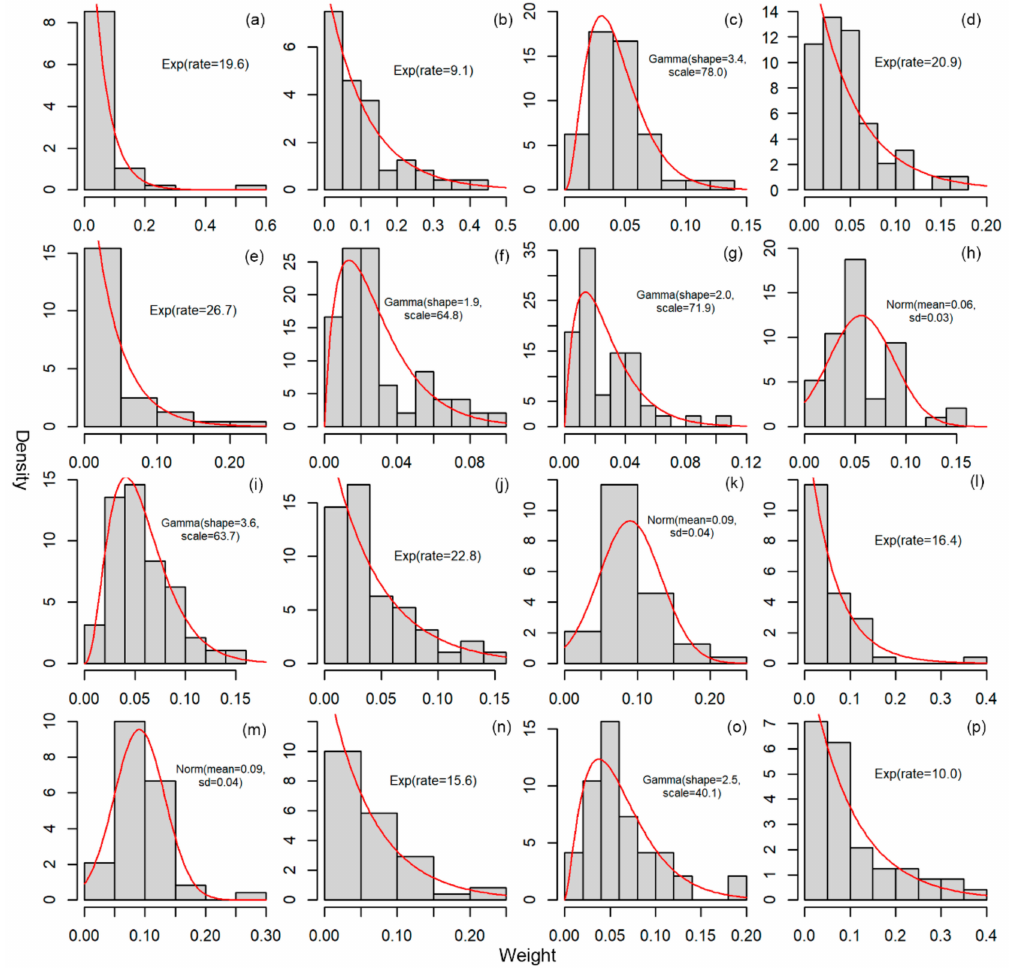
Figure 4. The density and fitted probability distribution of all AHP-derived weights based on a questionnaire survey by index. ( a – p ) represent di ff erent indices at the bottom level as shown in Table 1. We used the quartile method and set the breaks of intervals at the 90th, 80th, 60th, 40th percentile values to classify livability into 5 classes. The reason we chose this method is that the approximate ranking information can be gained from its class. For example, a community within the first class ranks in the top 10% of overall communities. The five classes included the first class (above 90th percentile), second class (81th–90th percentile), third class (61th–80th percentile), fourth class (41th–60th percentile), and fifth class (below 40th percentile). The higher the class is, the poorer the livability is. When a community lies in the fourth class, measures should be taken to improve some dimensions or indices of livability. A community, which lies at the lower 40th percentile, has overall poor livability, and all-round measures should be adopted to improve the livability. Which aspect(s) should be ameliorated can be identified from the assessment results by dimension or